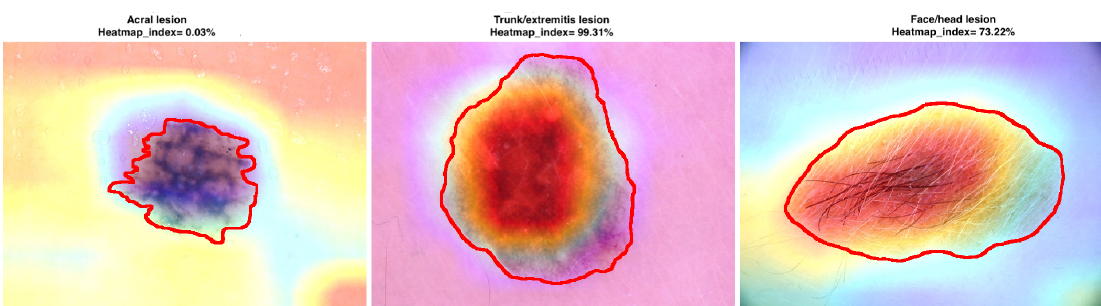
Figure 9. Examples of skin lesions originating in different anatomic sites with the corresponding heatmap created by the EfficientNetB0 model and segmentation ground-truth marked with red color. Heatmap index indicates to what extent the classification is based on the area of the skin